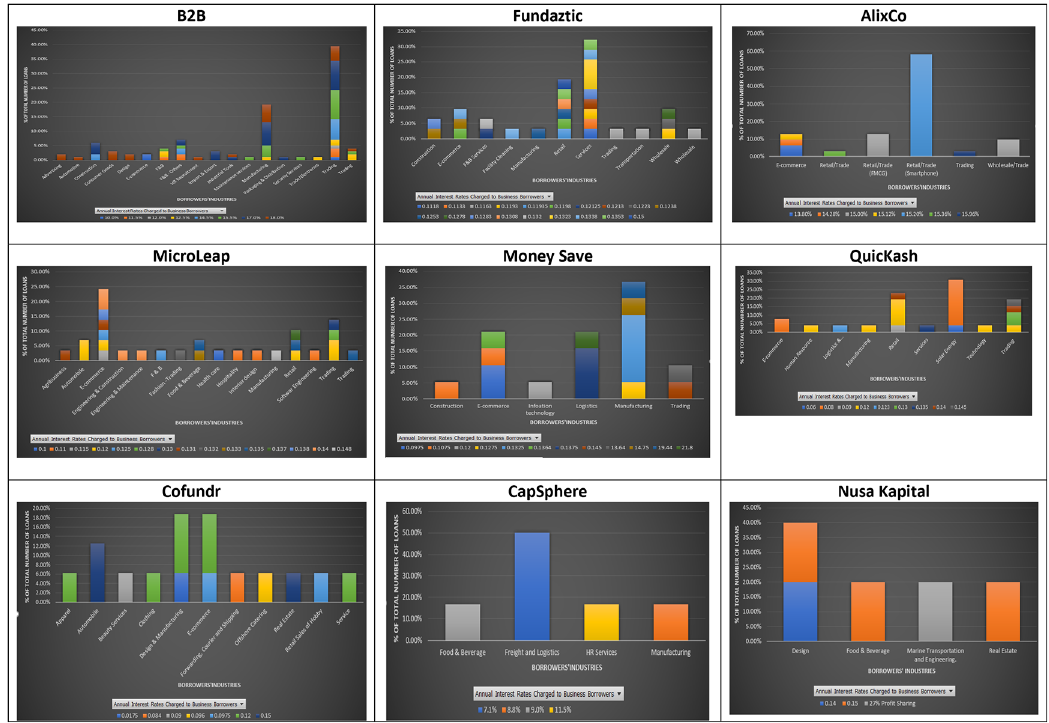
Figure 5. Interest rates and industries at nine P2P lending